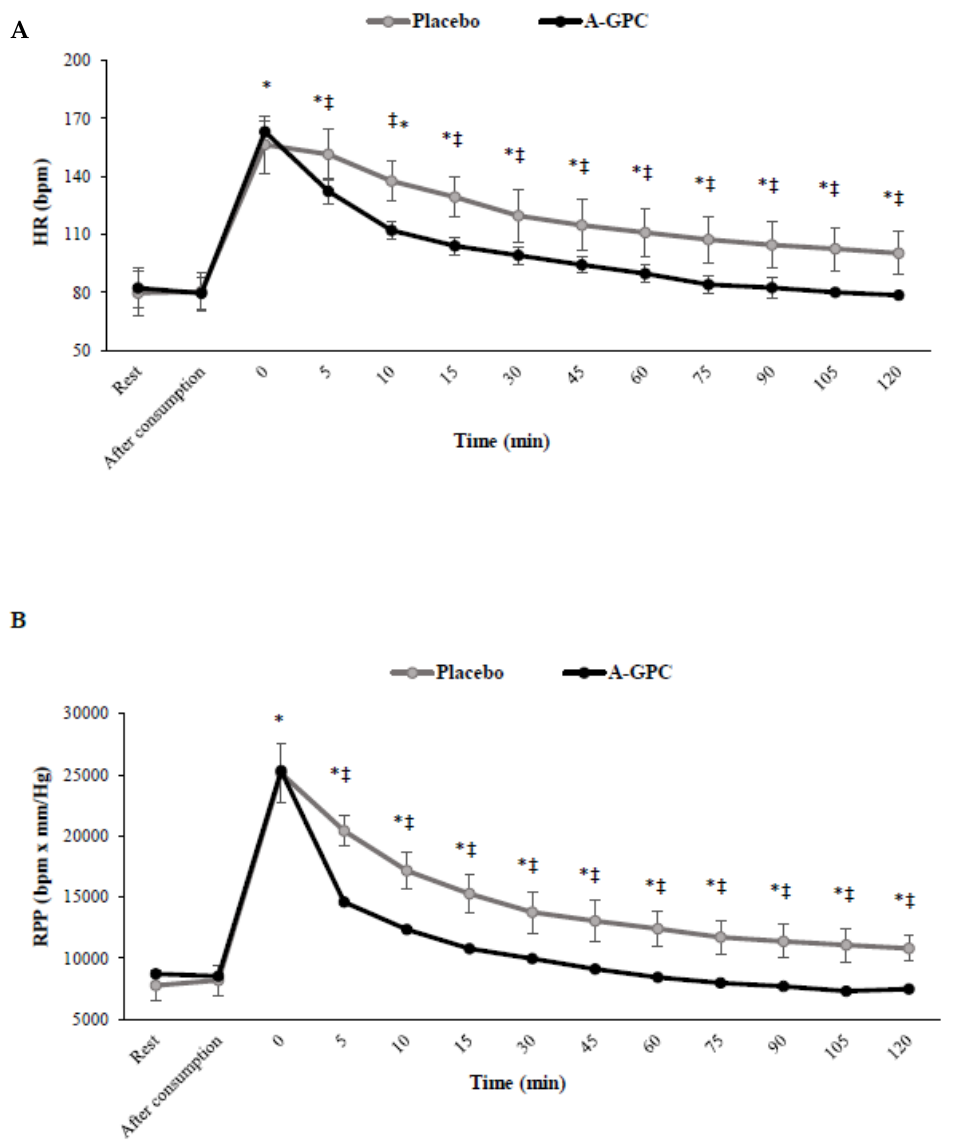
Figure 5. Heart rate ( A ) and Rate Pressure Product ( B ) at baseline, 60 min after choline or placebo consumption immediately after exercise and every 5 min during first 15 min and afterward every 15 min. HR, Heart Rate; RPP, Rate Pressure Product. Values are means ± SD. * indicates a significant difference from baseline ( p < 0.05); ‡ indicates a significant difference from placebo session ( p < 0.05).